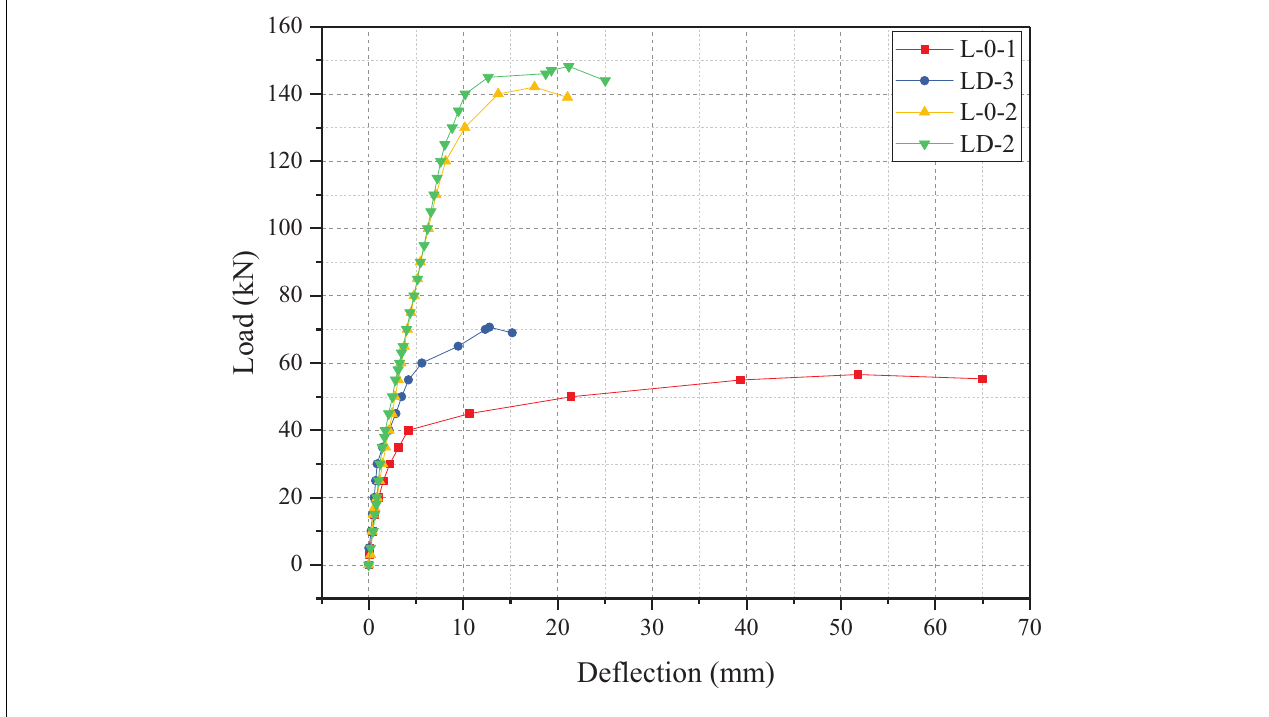
FIGURE 5 | Relationships between load and deflection.